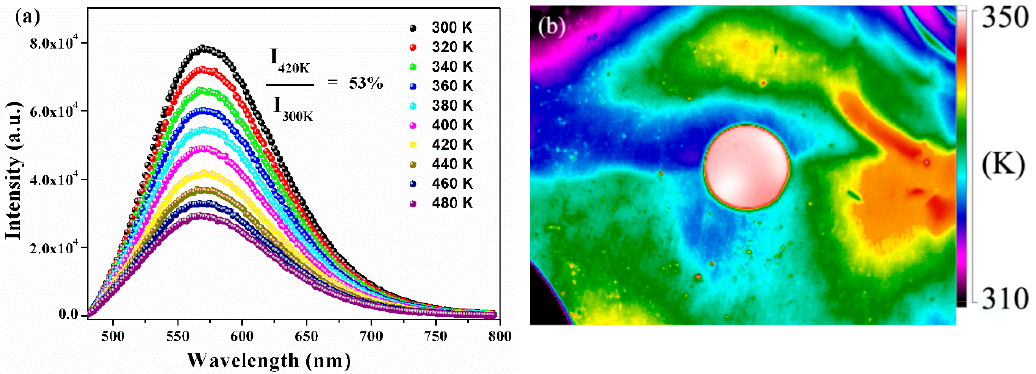
7 of 10 Figure 6. ( a ) The PL spectra of YMASG:0.05Ce 3+ and YMASG:0.05Ce 3+ PiG composite under 455 nm light excitation. ( b ) Decay curves of YMASG:0.05Ce 3+ and YMASG:0.05Ce 3+ PiG composite. The thermal stability of encapsulation materials played a significant role for the application of phosphor in the high-power LED field because the LED package would release heat during chip operation. The temperature-dependent PL spectra of as-synthesized YMASG:0.05Ce 3+ –PiG excited at 455 nm are given in Figure 7a. With increasing temperature, the emission intensity gradually decreased and the integrated intensity at 420 K was 53% of the initial intensity at room temperature. The temperature-dependent PL spectra of phosphor particles are shown in Figure S2. As the temperature elevated from 300 to 480 K, the integrated emission intensities gradually declined and the I em at 440 K dropped to 46% of the initial intensity. Particularly, the PiG sample possessed a slower rate of emission intensity decline compared with that of YMASG:0.05Ce 3+ due to its relatively high thermal conductivity (0.71·Wm − 1 ·K − 1 ) to release heat and subsequently reduce the possibility of the Ce 3+ ion nonradiative transition. Additionally, the weak shift observed in the PL spectra implies that the chromatic shifting of white LEDs will not arise during use. The CIE parameters of the phosphor and the corresponding PiG samples were measured and presented at different temperatures (as shown in Figure S3). The CIE coordinates of the PiG sample just slightly shifted from (0.483, 0.504) to